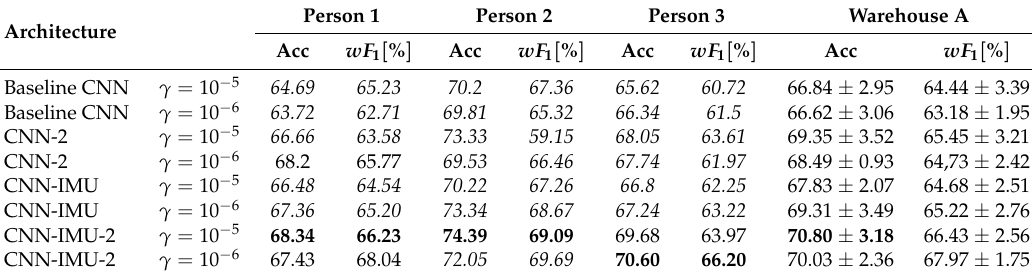
Table 12. Accuracies [ % ] and Weighted F1 [ % ] for warehouse A using CNN architectures. Architecture